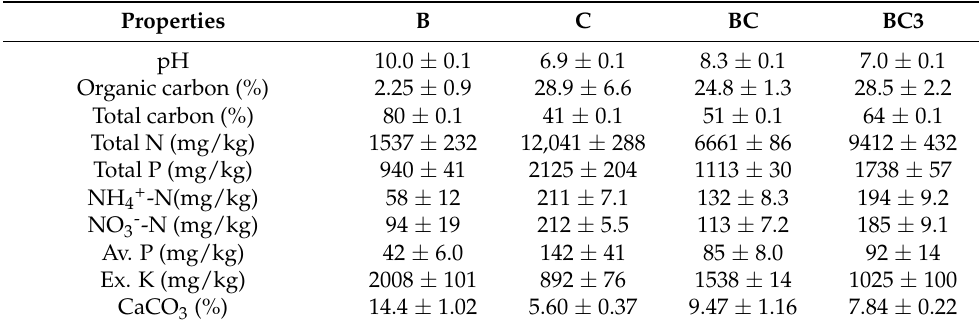
Table 2. Properties of the particle amendments in this